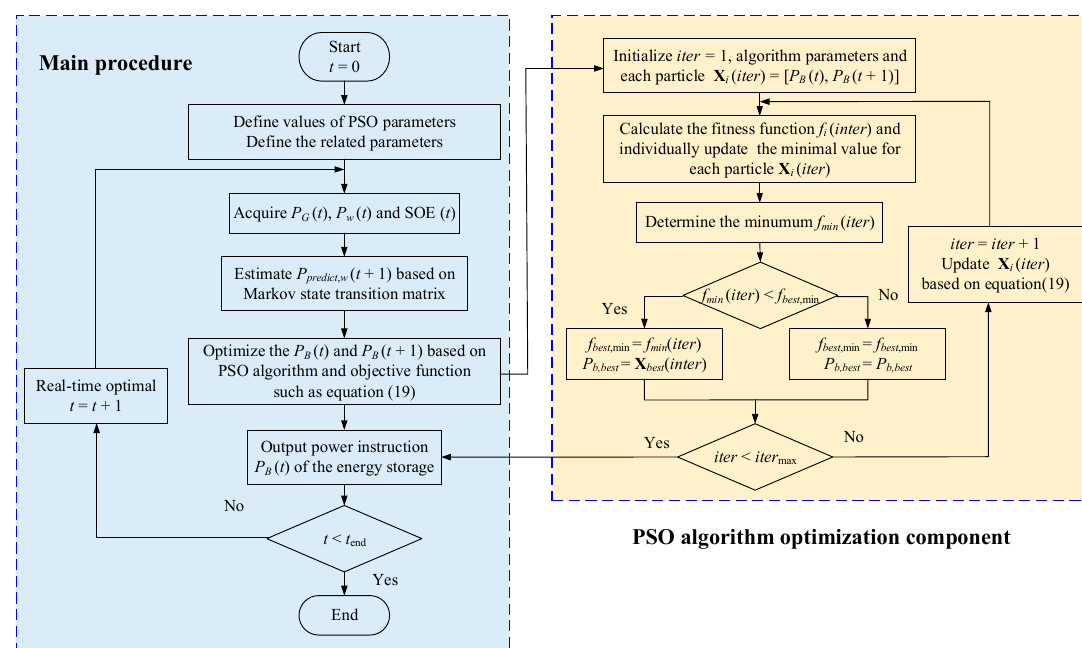
Figure 4. Flowchart of proposed method.